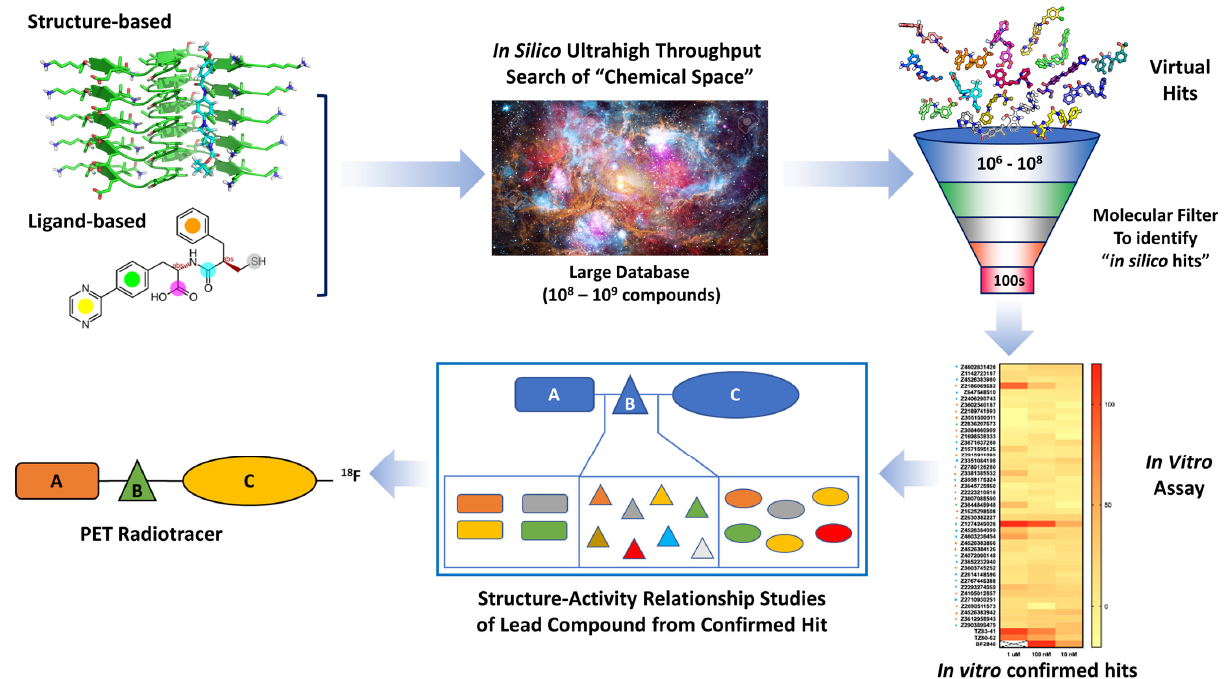
Figure 1. Workflow from VS to lead compounds identification for radiotracer development. “A, B, and C” in the last two steps of the workflow are represented as the fragment “A”, “B”, and “C” for structure–activity relationship studies.